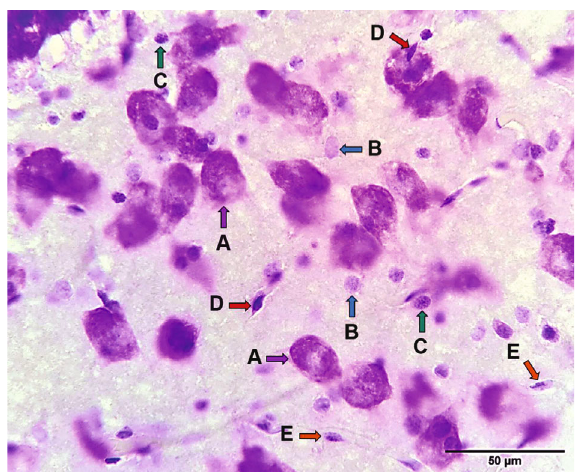
Figure 2: Neurons, glial cell types, and endothelial cells in a cresyl violet stained section of rat hippocampus. Neurons (A, purple arrows), astrocytes (B, blue arrows), oligodendrocytes (C, green arrows), microglia (D, red arrows), and endothelial cells (E, orange